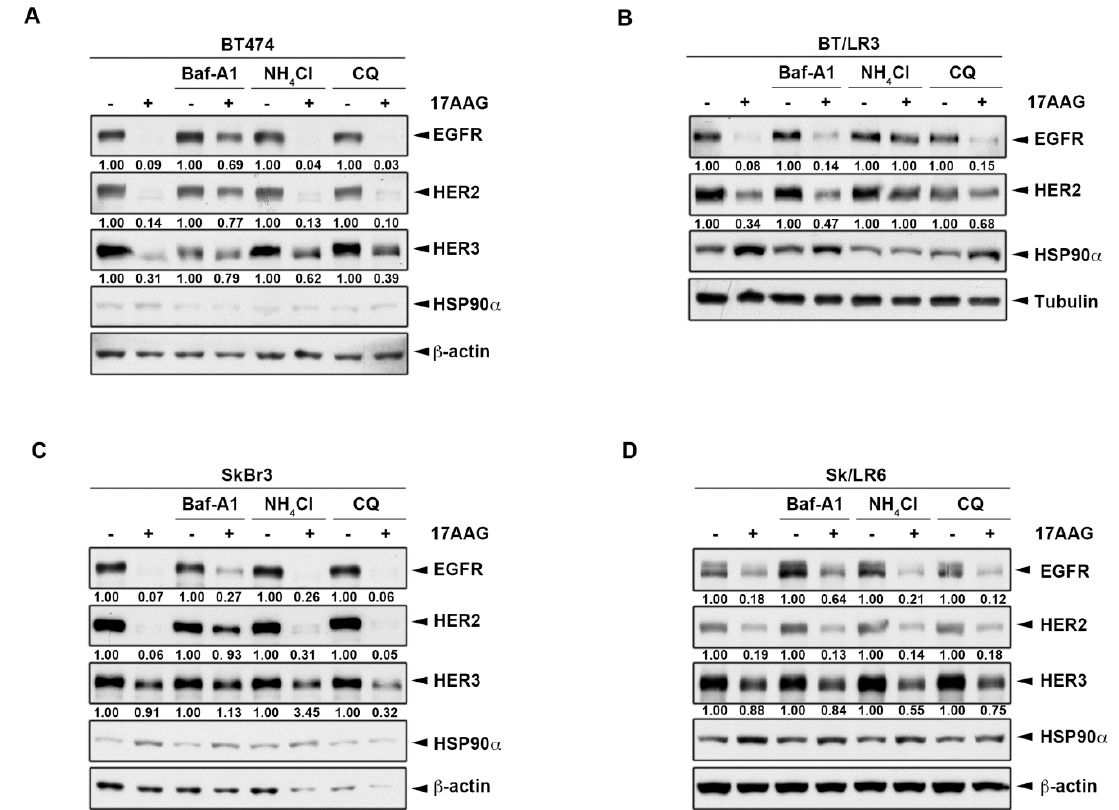
Figure 6. HSP90 inhibitors downregulate ErbB family expressions via the lysosomal pathway. BT474 ( A ), BT/LR3 ( B ), SkBr3 ( C ), and Sk/LR6 ( D ) cells were co-treated with 1 μ M 17AAG and lysosomal inhibitors 1 μ M Baf-A1, 10 mM NH 4 Cl, and 25 μ M CQ. Whole cell lysates were subjected to western blot analysis with indicated antibodies. The intensity of bands in western blot was quantitated using Image J, and β -actin was used as the loading control for normalization.